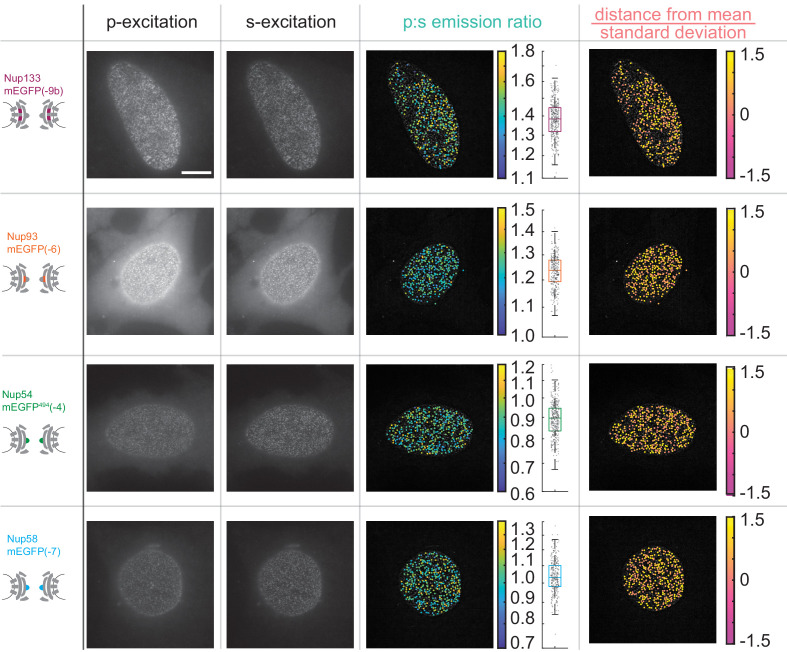
The orientation of Nup-mEGFP fusion proteins can be monitored with pol-TIRFM.Four different Nup-mEGFP (Nup133, Nup93, Nup54, and Nup58) were transiently expressed for 48 hr in HeLa cells. (Columns 1–2) The constructs were alternately excited with p^-polarized (perpendicular to the coverslip) and \hat{s}-polarized (parallel to the coverslip) light (Scale bar = 10 µm). (Column 3) The p:s ratios, a measurement of orientation of mEGFP relative to the coverslip are calculated for each NPC. The color of the dot represents the p:s ratio of the NPC upon which it is superimposed. The box plot represents the data directly taken from the cell next to it. Each dot represents the p:s measurement of a single NPC. (Column 4) The difference from the mean divided by the standard deviation is shown in the final column, illustrating how the p:s ratio does not vary with respect to the basal surface of the nucleus and that the cell holds its nuclear envelope parallel to the coverslip.Figure 1—figure supplement 1—source data 1.Source data for Figure 1—figure supplement 1.